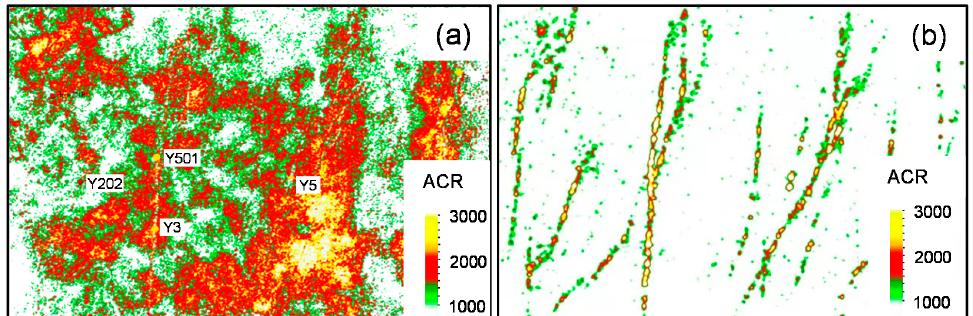
Figure 7. Comparison of ( a ) the amplitude change rate diagram of the original data and ( b ) the amplitude change rate diagram after multiple filtering processes of the top of the Middle Ordovician (ACR: amplitude change rate; modified after reference [16]).